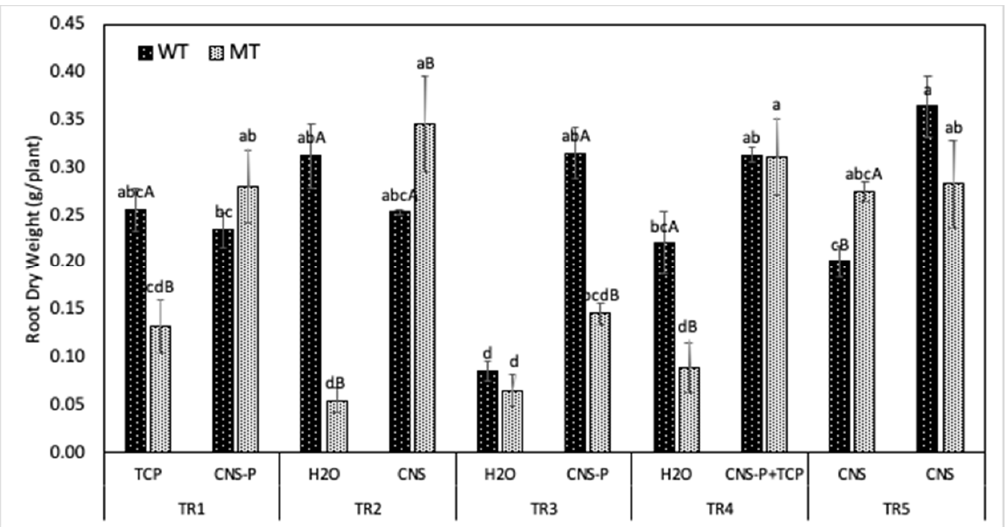
Figure 7. Root dry biomass of specific root section of two barley genotypes in a split-root system with the following P treatments: from left to right, the measurements followed the order: TR1-TCP/CNS-P; TR2-H 2 O/CNS; TR3-H 2 O/CNS-P; TR4-H 2 O/CNS-P + TCP; TR5-CNS/CNS. The root biomass was demonstrated for left and right root sections, respectively. Different lower-case letters indicate significant differences ( p ≤ 0.05) among the P treatments and different upper-case letters represent significant difference ( p ≤ 0.05) between the genotypes according to a Tukey’s HSD test. WT stands for root hair wild type, whereas MT means root hairless mutant.